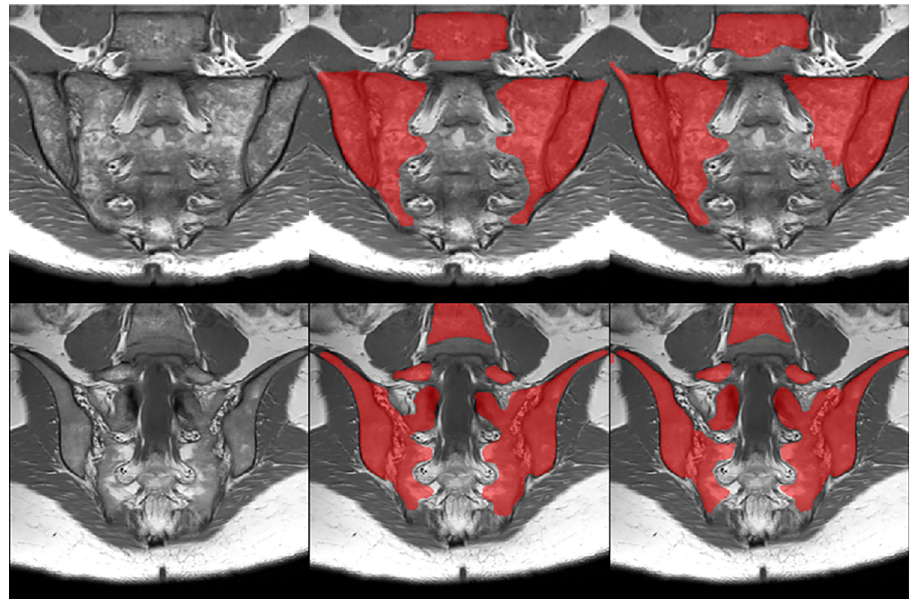
Fig 2. Automatic segmentation of disease region: Demonstration of performance on examples from the test dataset. The T1w images (left-hand column), reference standard (middle column) and model averaging ensemble prediction of disease region (right-hand column) are shown for illustrative slices from two subjects (top and bottom row).